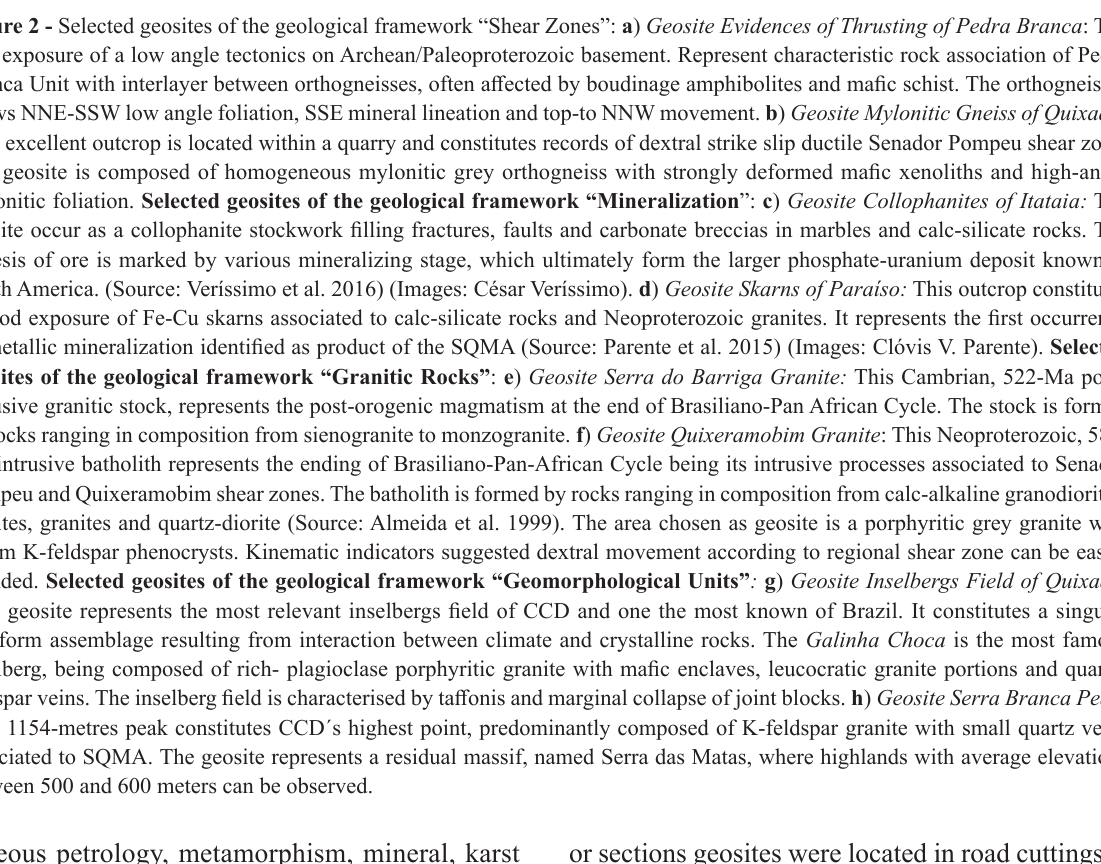
Figure 2 - Selected geosites of the geological framework “Shear Zones”: a ) Geosite Evidences of Thrusting of Pedra Branca : The best exposure of a low angle tectonics on Archean/Paleoproterozoic basement. Represent characteristic rock association of Pedra Branca Unit with interlayer between orthogneisses, often affected by boudinage amphibolites and mafic schist. The orthogneisses shows NNE-SSW low angle foliation, SSE mineral lineation and top-to NNW movement. b ) Geosite Mylonitic Gneiss of Quixadá: This excellent outcrop is located within a quarry and constitutes records of dextral strike slip ductile Senador Pompeu shear zone. The geosite is composed of homogeneous mylonitic grey orthogneiss with strongly deformed mafic xenoliths and high-angle mylonitic foliation. Selected geosites of the geological framework “Mineralization ”: c ) Geosite Collophanites of Itataia: The geosite occur as a collophanite stockwork filling fractures, faults and carbonate breccias in marbles and calc-silicate rocks. The genesis of ore is marked by various mineralizing stage, which ultimately form the larger phosphate-uranium deposit known in South America. (Source: Veríssimo et al. 2016) (Images: César Veríssimo). d ) Geosite Skarns of Paraíso: This outcrop constitutes a good exposure of Fe-Cu skarns associated to calc-silicate rocks and Neoproterozoic granites. It represents the first occurrence of metallic mineralization identified as product of the SQMA (Source: Parente et al. 2015) (Images: Clóvis V. Parente). Selected geosites of the geological framework “Granitic Rocks” : e ) Geosite Serra do Barriga Granite: This Cambrian, 522-Ma poly- intrusive granitic stock, represents the post-orogenic magmatism at the end of Brasiliano-Pan African Cycle. The stock is formed by rocks ranging in composition from sienogranite to monzogranite. f ) Geosite Quixeramobim Granite : This Neoproterozoic, 587- Ma intrusive batholith represents the ending of Brasiliano-Pan-African Cycle being its intrusive processes associated to Senador Pompeu and Quixeramobim shear zones. The batholith is formed by rocks ranging in composition from calc-alkaline granodiorites, diorites, granites and quartz-diorite (Source: Almeida et al. 1999). The area chosen as geosite is a porphyritic grey granite with 15 cm K-feldspar phenocrysts. Kinematic indicators suggested dextral movement according to regional shear zone can be easily founded. Selected geosites of the geological framework “Geomorphological Units” : g ) Geosite Inselbergs Field of Quixadá : This geosite represents the most relevant inselbergs field of CCD and one the most known of Brazil. It constitutes a singular landform assemblage resulting from interaction between climate and crystalline rocks. The Galinha Choca is the most famous inselberg, being composed of rich- plagioclase porphyritic granite with mafic enclaves, leucocratic granite portions and quartz- feldspar veins. The inselberg field is characterised by taffonis and marginal collapse of joint blocks. h ) Geosite Serra Branca Peak: This 1154-metres peak constitutes CCD´s highest point, predominantly composed of K-feldspar granite with small quartz veins associated to SQMA. The geosite represents a residual massif, named Serra das Matas, where highlands with average elevations between 500 and 600 meters can be